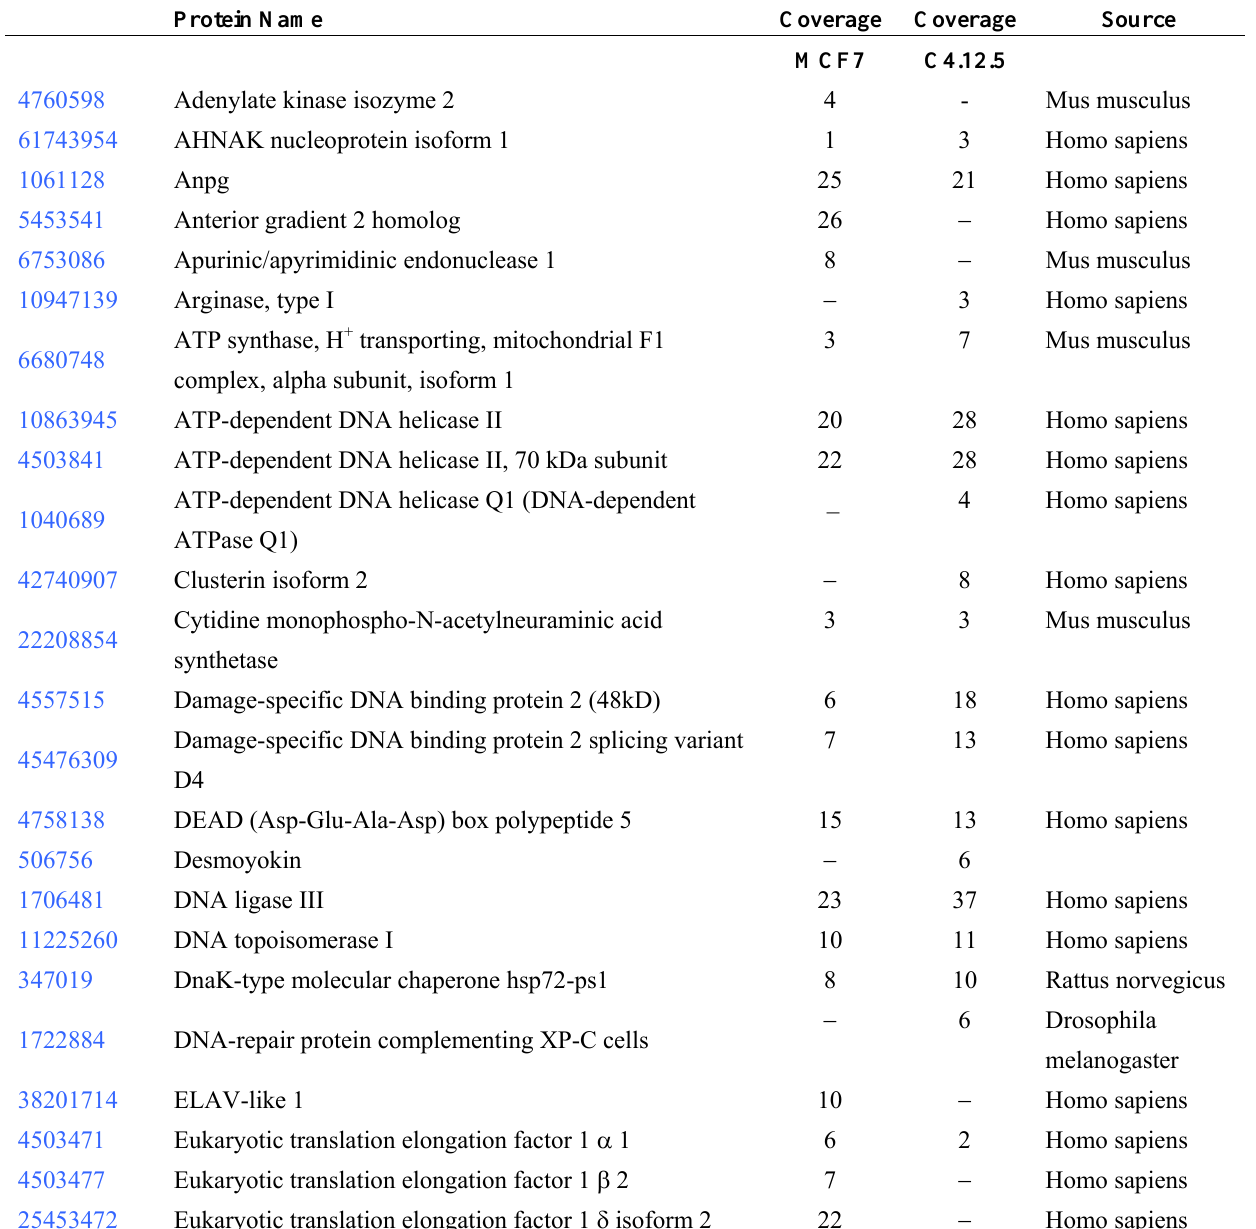
Table 1. IGF-IR promoter-binding proteins identified by MS in MCF7 and C4.12.5